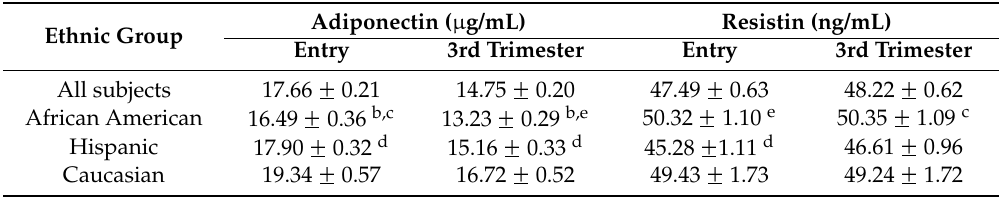
Table 2. Difference in adiponectin and resistin concentrations by ethnicity a